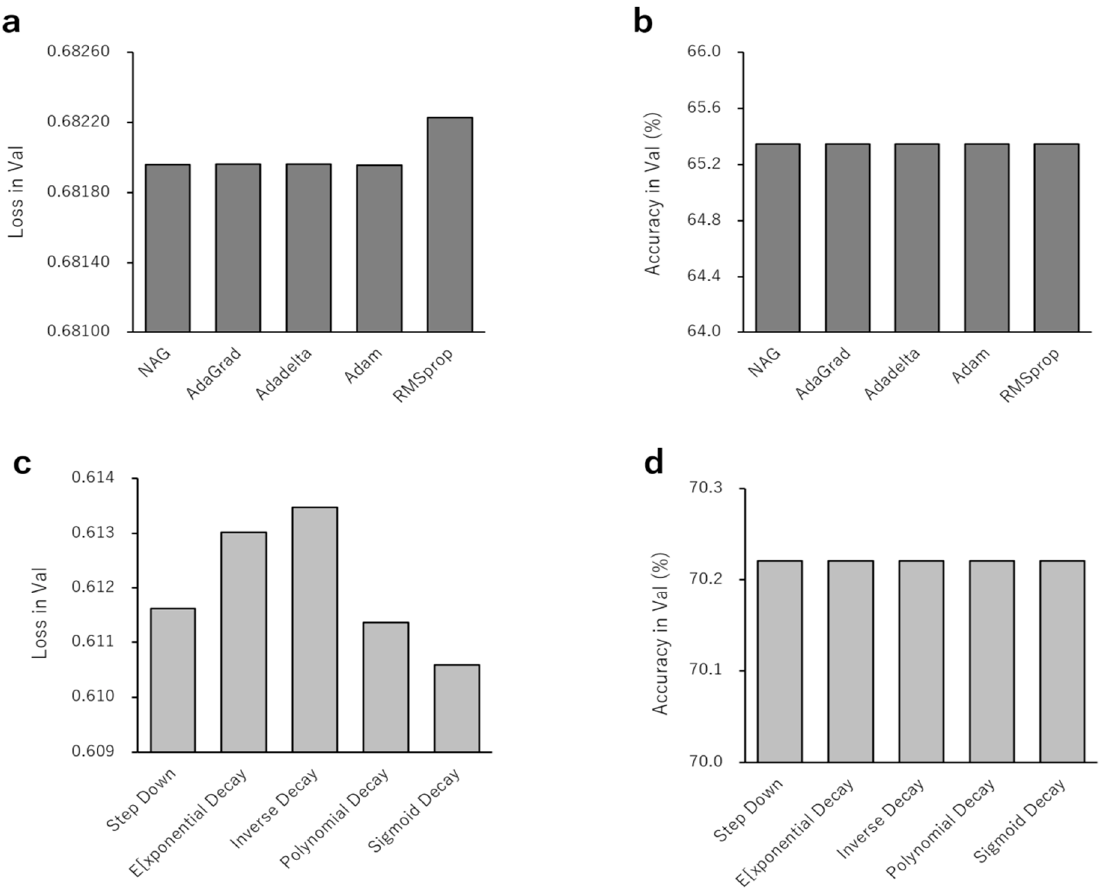
Figure 4. Performances of the DL prediction models with different solver types ( a , b ) and policies ( c , d ). Plotted are the loss values ( left ) and accuracies ( right ) with the validation dataset.